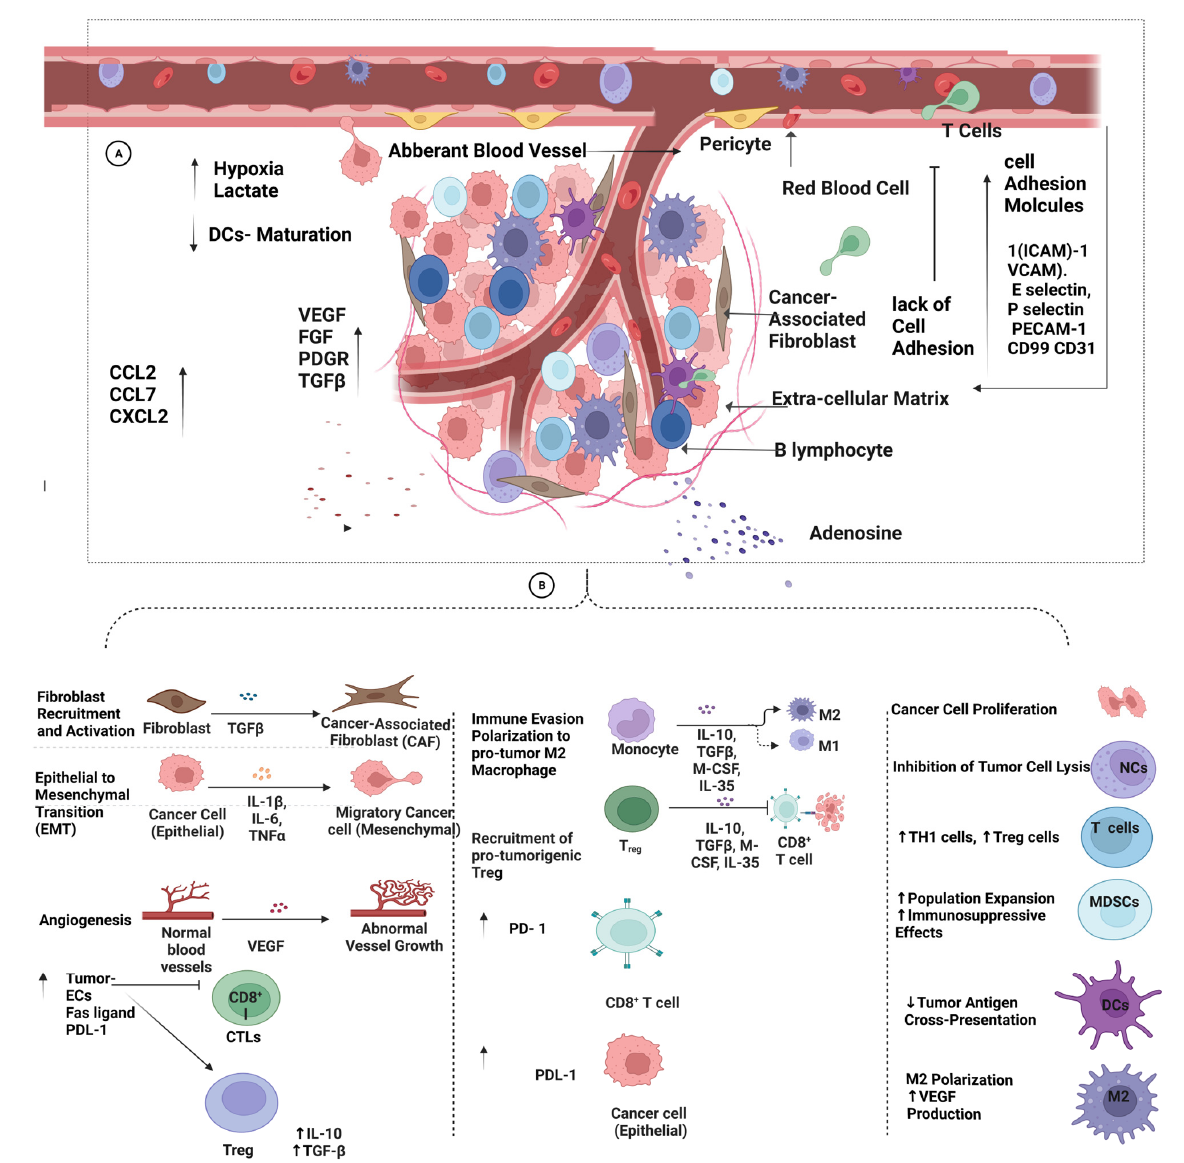
Figure 4. Schematic presentation of the extrinsic factors contributing to tumor resistance against immunotherapy. ( A ) Tumor growth and the hypoxic effect on the TME trigger the expression of immunosuppressive and proangiogenic factors, such as TGF-B, VEGF, EGF, FGF, and PDGF. Various vascular changes are mediated by VEGF and immunosuppressive factors, including dysfunctional blood vessels and a lack of both epidermal cells and cell-adhesion molecules (ICAM, P-selectin, and E-selectin). These changes prevent the infiltration of immune cells into the TME and downregulate the immune response. Furthermore, aberrant blood vessels lead to a more stressful and enriched environment, with acidic and hypoxic factors that increase VEGF and prevent DC maturation. Chemokines, such as CCL2, CCL7, and CXCL2 abate/elevate tumor–immune responses and recruit MDSCs, which support tumor growth via TGF-ß. ( B ) In the tumor microenvironment (TME), further immunosuppressive changes have been observed, such as elevated PD-L1 levels in tumor cells and myeloid-derived suppressor cells (MDSCs), the activation of oxidative and fatty acid metabolism pathways in inactive and resting T cells, and a shortage of glucose that hinders the function of IL-2-stimulated T cells and interferon-gamma (IFN- γ ) production.. The upregulation of the TME’s metabolites, such as adenosine, which is produced by TAMs and Tregs, acts as a mediator of immunosuppression. Created with